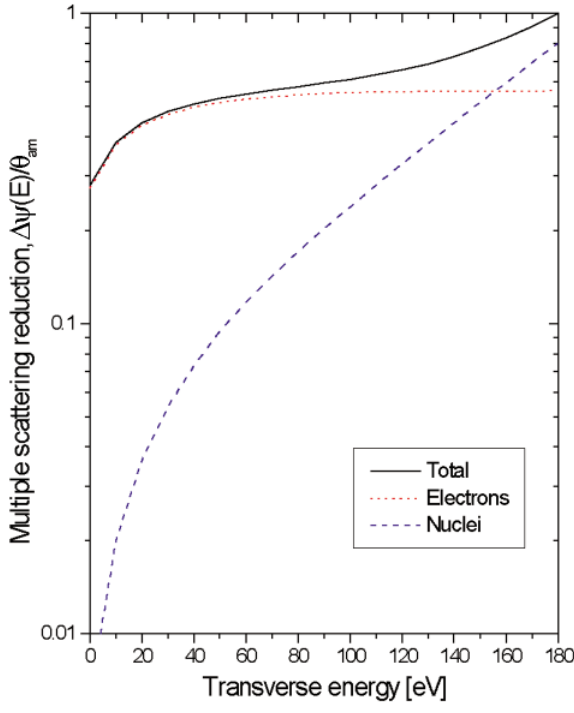
FIG. 5. (Color) The beam size at the position of the stripper foil as a function of the number of turns in the machine. The solid line is for a diamond, while the dotted line is for an amorphous carbon target, both of 240 m g (cid:2) cm 2